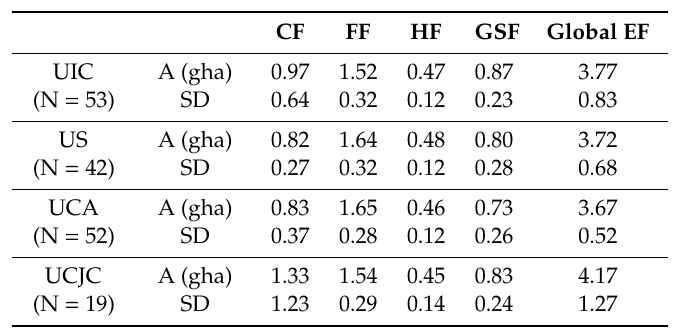
Table 4. Global EF and disaggregated by category, for education (primary or pre-school) degree students at four Spanish Universities: UIC (Barcelona), US (Seville), UCA (C á diz) and UCJC (Madrid). The data of the global EF an disaggregated bay category of each student is provided as supplementary material (Table S1).